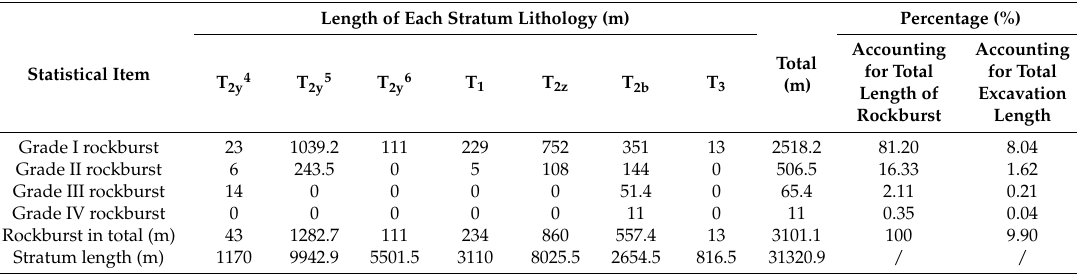
Table 1. Statistics of the rockburst length in different stratum.